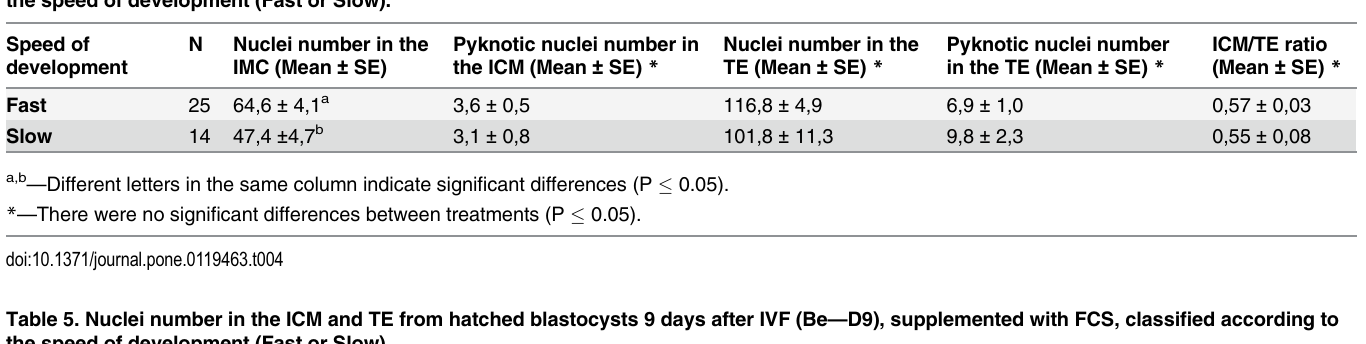
Table 5. Nuclei number in the ICM and TE from hatched blastocysts 9 days after IVF (Be — D9), supplemented with FCS, classi fi ed according to the speed of development (Fast or Slow). Speed of